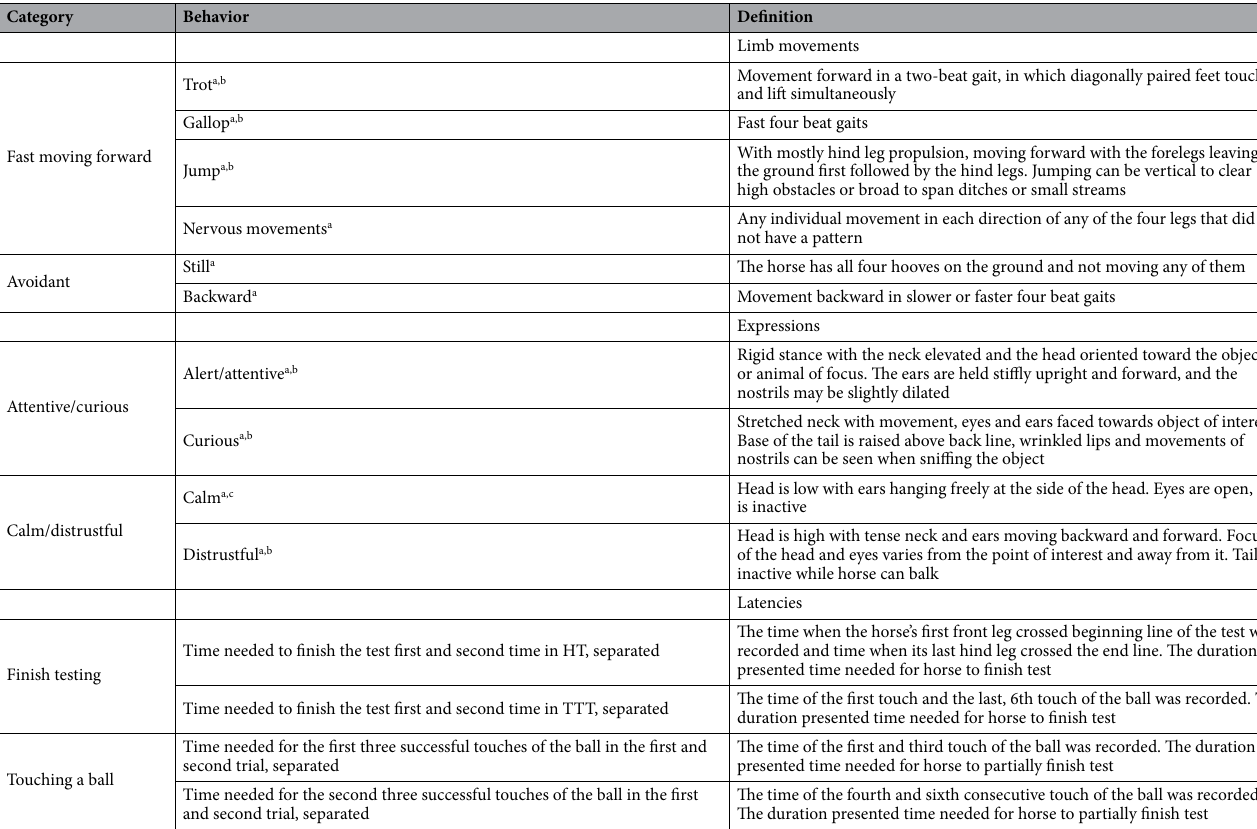
Table 4. Behaviours recorded during the behavioural tests and their definitions. TTT target raining test, HT handling test. a Duration. b McDonnell 48 . c Draaisma 34 . d Values represent percentage (%) of the total testing